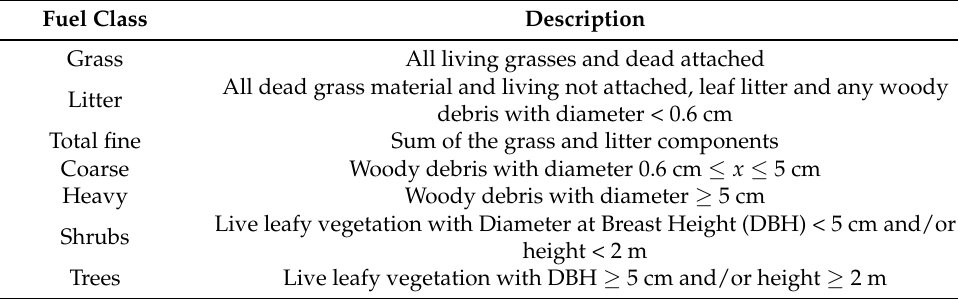
Table 1. Summary of the fuel classes measured at the ground level in each plot.